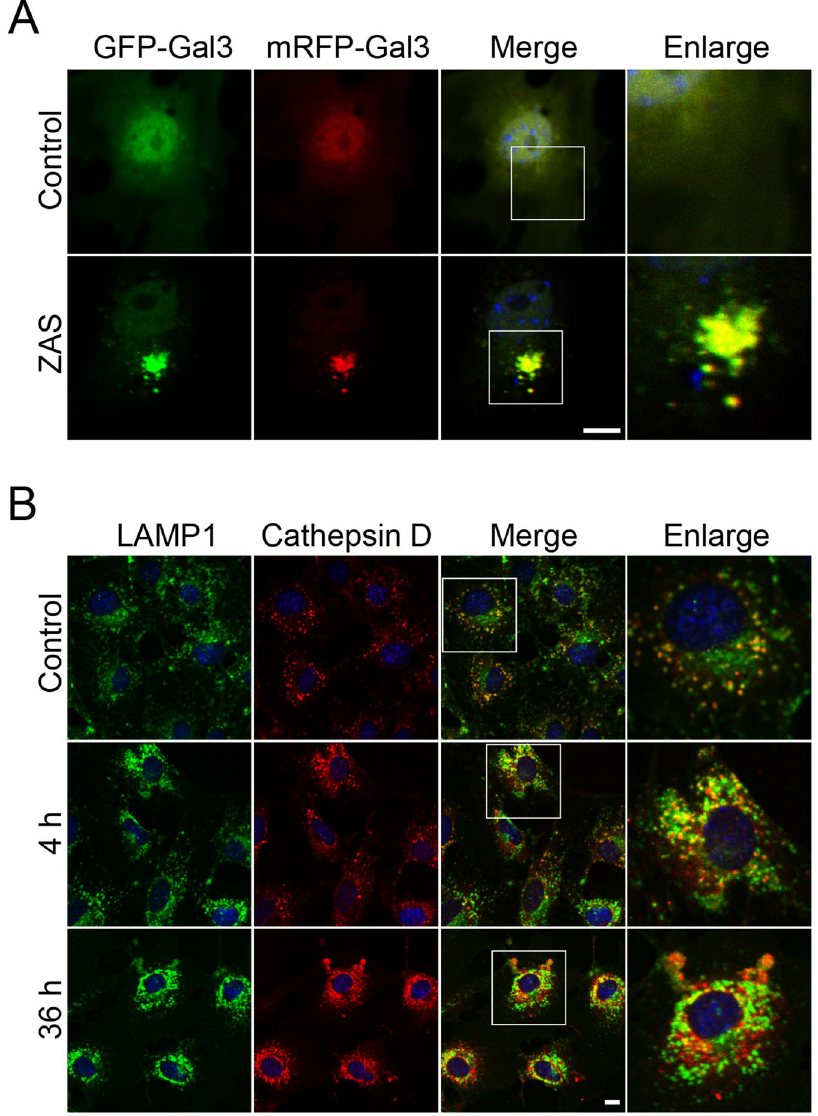
Figure 11. Lysosomal membrane permeabilization triggered by zymosan activation serum (ZAS). ( A ) The cultured podocytes were transfected with tandem fluorescent-tagged Galectin-3 (tfGal3) plasmid, which can accumulate inside the ruptured lysosomes, followed by treatment with heat-inactivated human serum (HIS) or ZAS for 4 h. Representative fluorescence images show that tfGal3 puncta (mRFP + GFP + ) were clustered in ZAS- treated podocytes, indicating membrane rupture in the lysosomes. ( B ) Immunofluorescent double-staining with LAMP1 and cathepsin D in podocytes after exposure to HIS (control) and ZAS for 4 h or 36 h. The red immunofluorescence shows the leakage of cathepsin D (red) from the lysosomes in the cytoplasm accompanied by irregular LAMP1 (green) granules at 36 h. Scale bar, 10 μ